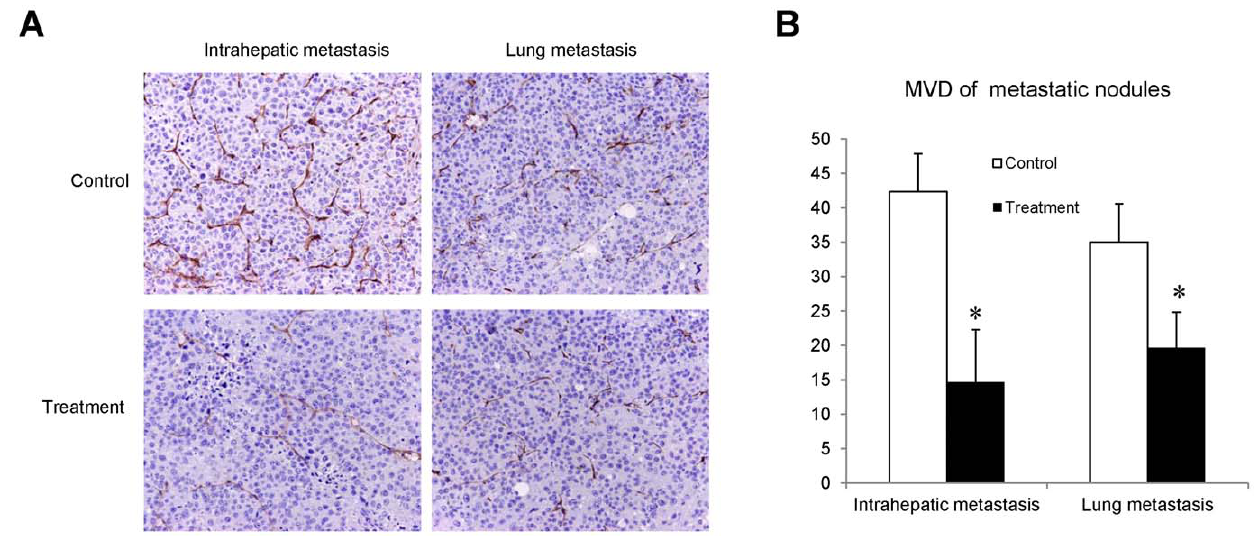
Figure 3. Comparison of tumor angiogenesis in metastatic tumor nodules. (A) The expression of CD34 positive cells in intrahepatic and lung metastatic tumor nodules. (B) Comparison of MVD in metastatic tumor nodules between treatment group and control group. Each group contained 16 rats, *P , 0.05 .